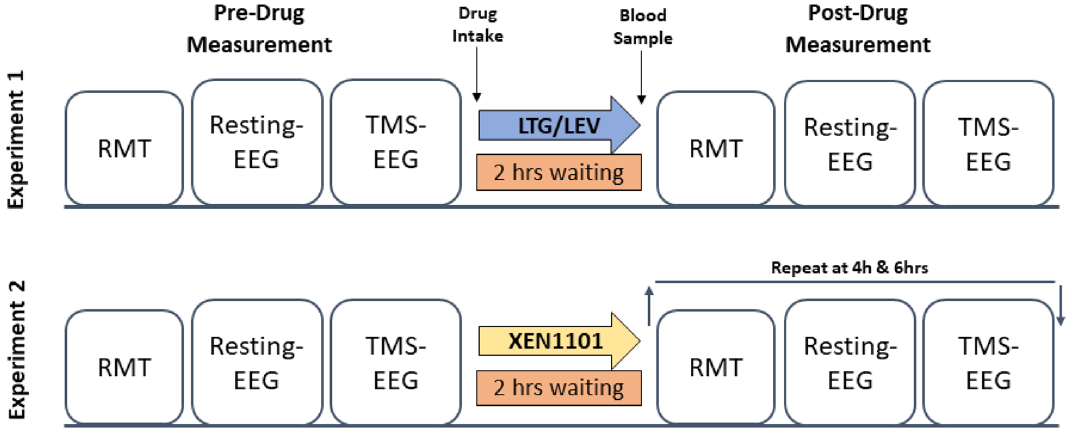
Figure 1. Experimental protocol and timeline. Lamotrigine, Levetiracetam and placebo were administered on separate occasions in experiment 1 and XEN1101 and placebo on separate occasions in experiment 2. Both studies followed a randomized and crossover design. RMT, Resting-state EEG and TMS-EEG sessions were recorded for each subject at baseline (pre-drug measurement) and at 2 (experiment 1 and 2), 4 and 6 h (experiment 2) after drug intake. Five minutes before each post-drug measurement a blood sample was taken to measure drug plasma sample was taken for every subject to evaluate drug plasma concentration. XEN1101 showed a pharmacoki- netic profile characterized by a prolonged absorption and XEN1101 was detectable (< 8.22 ng/mL) a week after administration, during the placebo experiment in those subjects who had placebo at the second visit 14 . Therefore, to investigate XEN1101 effects, we selected post-dose measures for TMS-EEG and resting EEG measurements taken during the highest drug exposure (> 8.22 ng/mL) at the time of the post-drug TMS session (Supplementary Table 1). The same timing of post-drug measurement was chosen to perform a time-matched placebo comparison at individual level. Analysis of TMS‑related spectral perturbation (TRSP). To investigate the effects of different AEDs on TMS-related spectral perturbation (TRSP), the whole EEG signal was analysed using MATLAB® (Mathworks Ltd, USA, R2012b) (The Mathworks Inc.) and FieldTrip toolbox 25 . TRSP is defined as the event-related changes in spectral power over time in a broad frequency range and it takes into account the phase-locked and non-phase locked EEG perturbations induced by TMS 8,26 . After excluding trials with prominent eye movements, blinks, and muscle artefacts (on the basis of visual inspection), data were segmented into epochs of 1 s length before and after the TMS pulse, and linearly inter- polated for ± 10 ms to remove the TMS artefact. Bad channels were removed from the EEG, and the signal was reconstructed by interpolating the surrounding electrode signals. Data were then notch-filtered (50 Hz) and down-sampled to 1 kHz. Independent Component analysis (ICA) was applied to remove TMS-related artifacts (i.e., cranial muscle response, recharge of capacitors, and related exponential decay artifacts 27–29 ), as well as further muscle and ocular activity. Finally, remaining data were re-referenced to the linked mastoids, baseline corrected (from − 1000 to − 50 ms) and band-pass filtered (1–80 Hz). The time–frequency representations were calculated by applying a Hanning taper windowed fast Fourier transform (FFT) with frequency-dependent window length (width: 3.5 cycles per time window, time steps: 10 ms, frequency steps: 1 Hz from 2 to 45 Hz) 26 . We then applied a single-trial z-transformation, based on the mean and standard deviation of the full-length trial and baseline-corrected by subtracting the mean value of the baseline period (from – 1000 to 50 ms before TMS) 17 . For each drug condition in both experiments, TMS-related oscillations were classified in delta (2–4 Hz), theta (4–7 Hz), alpha (8–12 Hz), beta (13–30 Hz) and gamma (30–45 Hz) frequency bands. Analysis of resting‑state EEG.